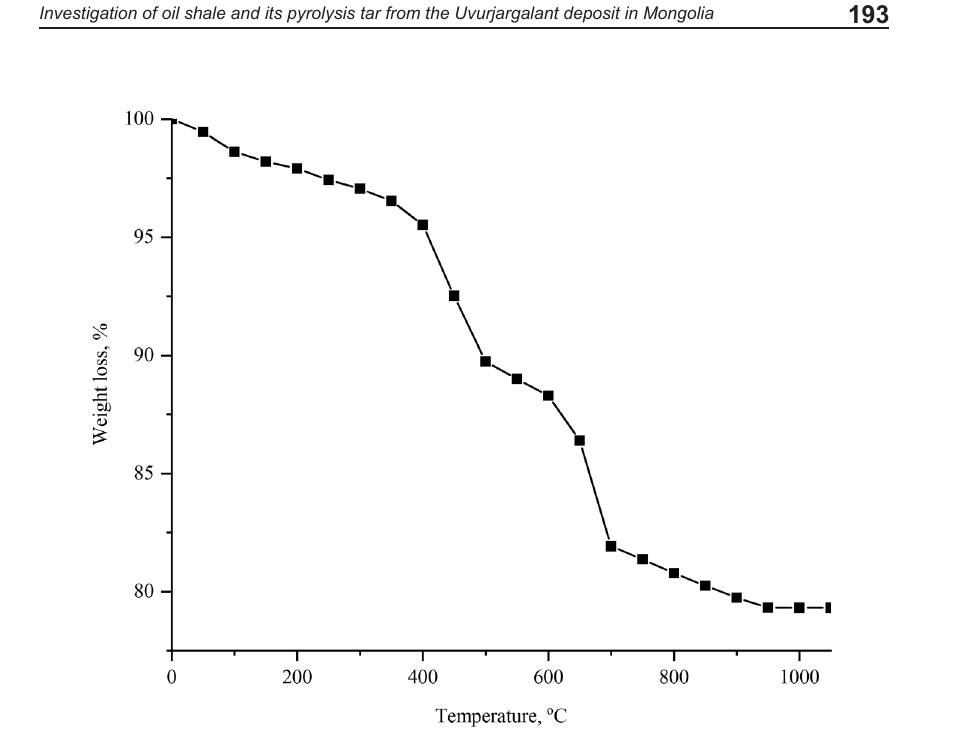
Fig. 1. The TG curve for the weight loss of Uvurjargalant oil shale during the thermal decomposition